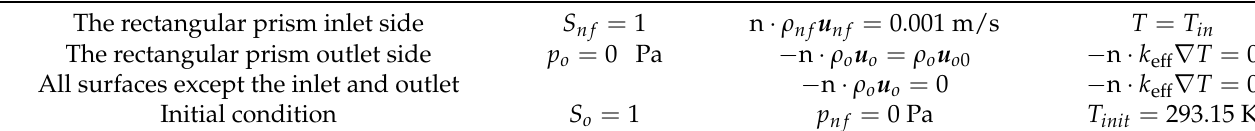
Table 4. Boundary conditions.